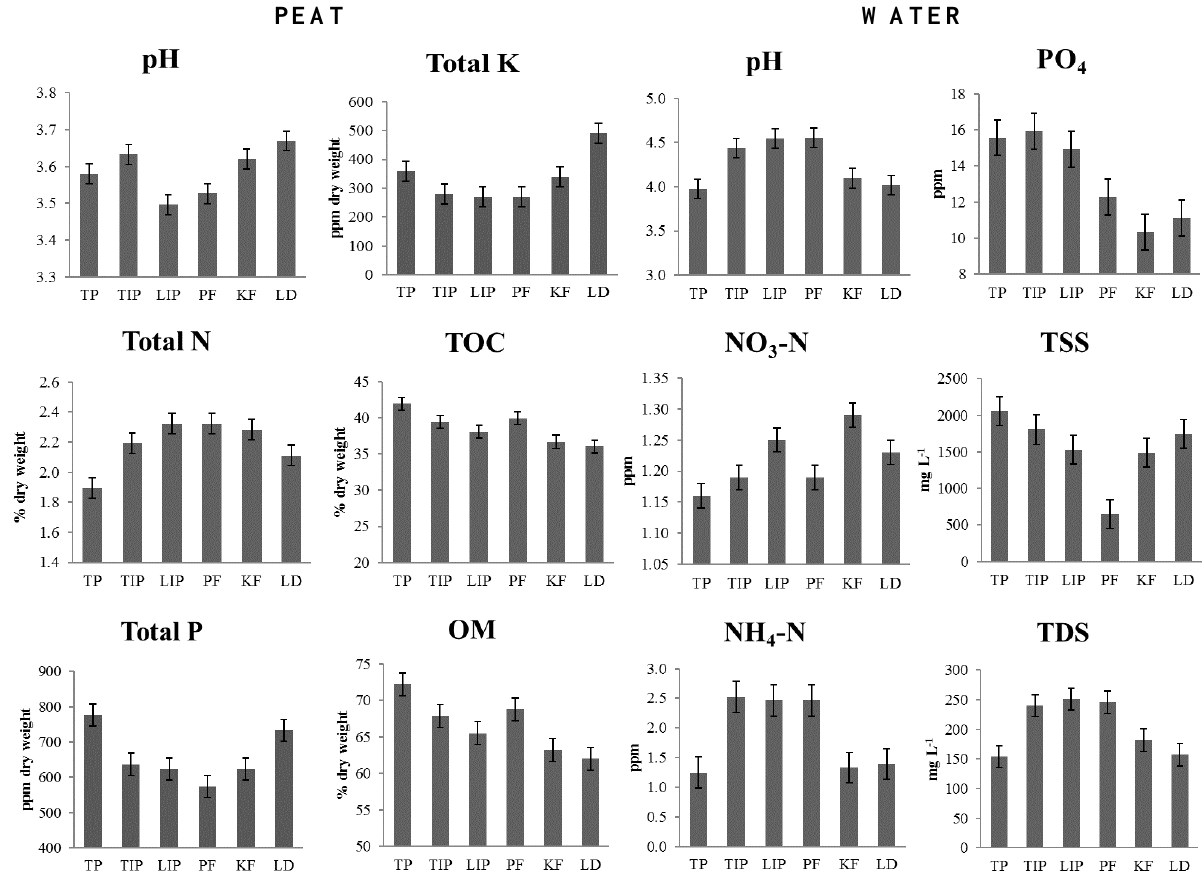
Figure 5. Chemical properties of peat and water in the six forest types/plant communities at Caimpugnan: TP = tall pole, TIF = tall intermediate, LIF = low intermediate, PF = pygmy and KF = Kasawangan forest; LD = Lycopodium-Dicranopteris community. TOC = total organic carbon; OM = organic matter; TSS = total suspended solids; TDS = total dissolved solids. The error bars indicate ±